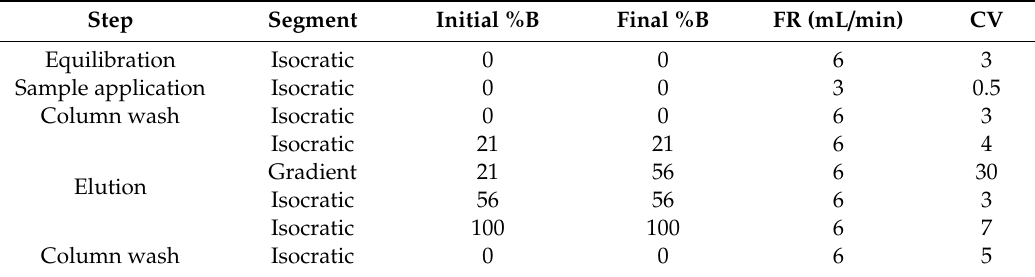
Table 4. N. ashei venom fractionation